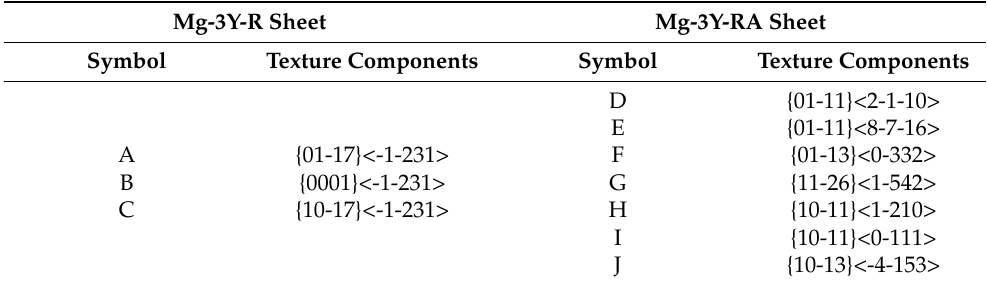
Figure 21. ODF sections of as-rolled Mg-3Y sheet (A, B and C are different texture component mark). Table 3. Major texture components of Mg-3Y alloy